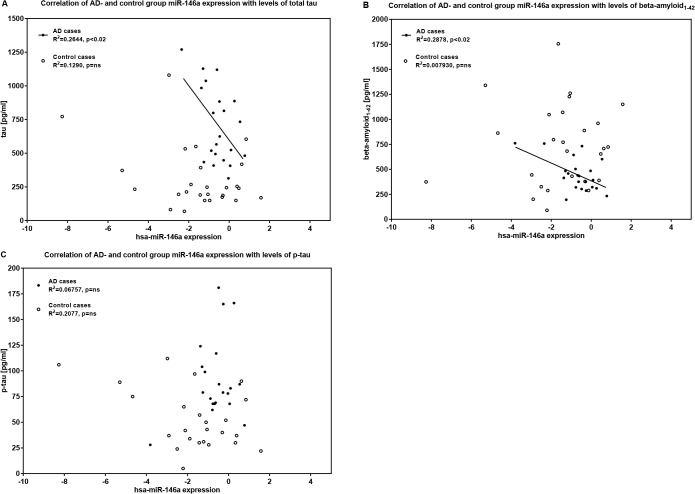
Scatter plot: Correlation of CSF miR-146a expression and levels of total tau, p-tau and Aβ1–42.Correlation significances were proven by Pearson correlation coefficients. Data were analysed applying Cq 32 as cut-off for miR-146a expression levels. Expression levels of miR-146a (2^-dCt log2) are inversely correlated with concentrations of total tau and Aβ1–42 in the AD group: (A) miR-146a expression levels vs. tau, AD cases: r = -0.5142, 98% CI -0.8065 to -0.01993, p = 0.0171; (B) miR-146a expression levels vs. Aβ1–42, AD cases: r = -0.5364, 98% CI -0.8121 to -0.06519, p = 0.0101. (C) No significant correlations were observed for concentrations of p-tau and miR-146a expression levels in the AD- and control group. Aβ1–42 = b-amyloid 42; CI = confidence interval; p-tau = phosphorylated tau.